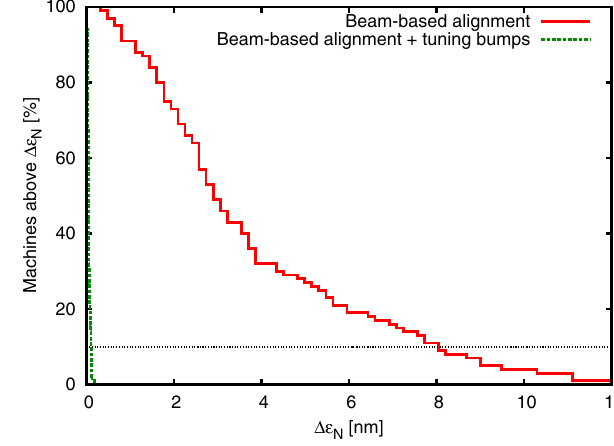
FIG. 23. Emittance growth reduction at the end of the ILC linac using four knobs. The performance is nearly identical for knobs based on all quadrupoles of the linac and knobs based on a set of 20 quadrupoles.